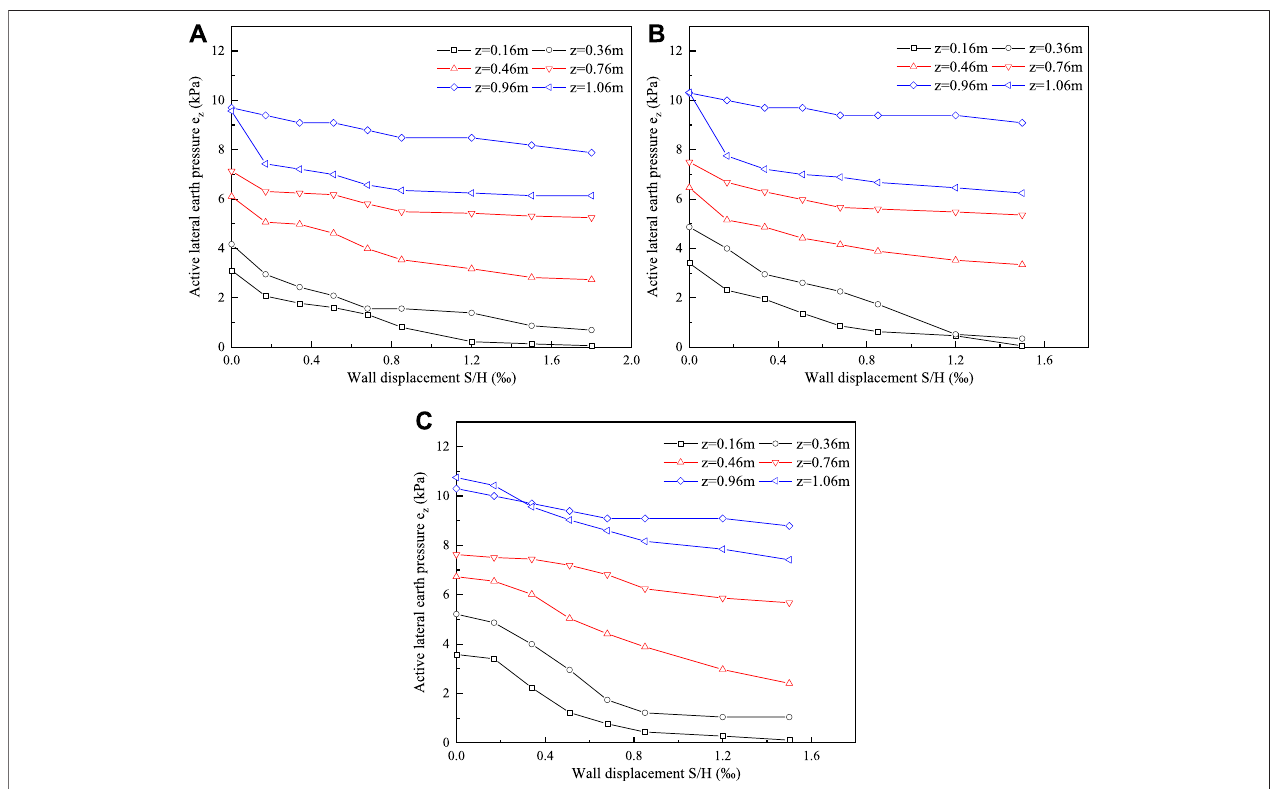
FIGURE 9 | Changes of Active Lateral Earth Pressure with Wall Rotation Displacement in Model Experimental. (A) β = 40 ° . (B) β = 50 ° . (C) β = 60 ° .